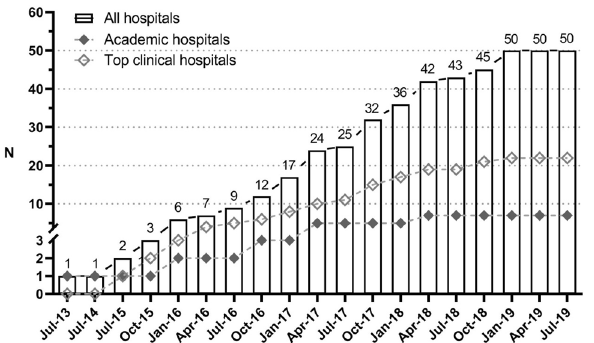
Figure 2. PLCRC recruiting hospitals (academic, non-academic, and top clinical hospitals) over time. Note: In The Netherlands there is a total of 75 hospitals, of which 8 academic hospitals and 26 top-clinical hospitals.